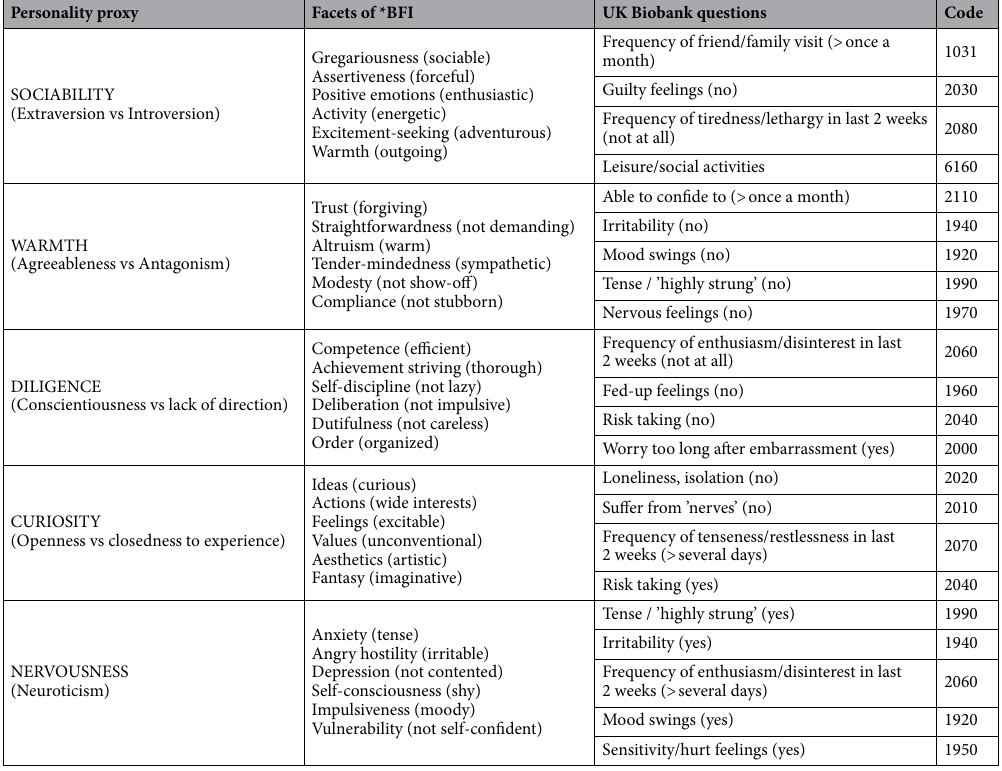
Table 1. Big Five proxies derived from UK Biobank variables. *Big Five Inventory (BFI) (John and Srivastava 12